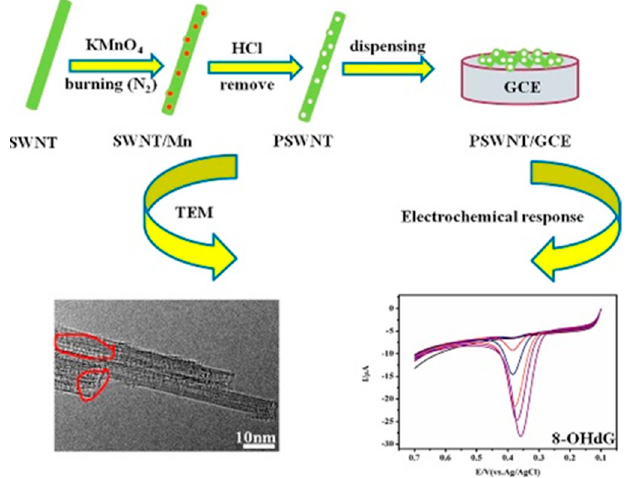
Figure 3. The application of porous single-walled carbon nanotube (PSWCNT) for the determination of o 8 dGuo. Reprinted with permission from Reference [29]. © 2018, Elsevier.